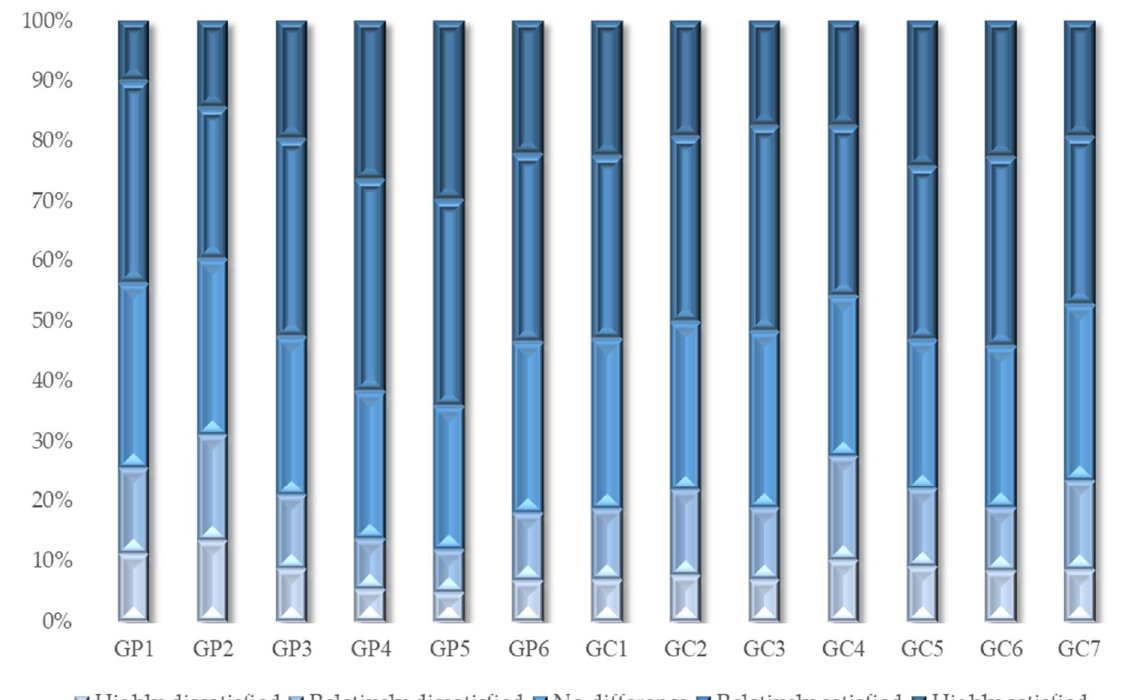
Figure 5. Results of satisfaction with government regulation.